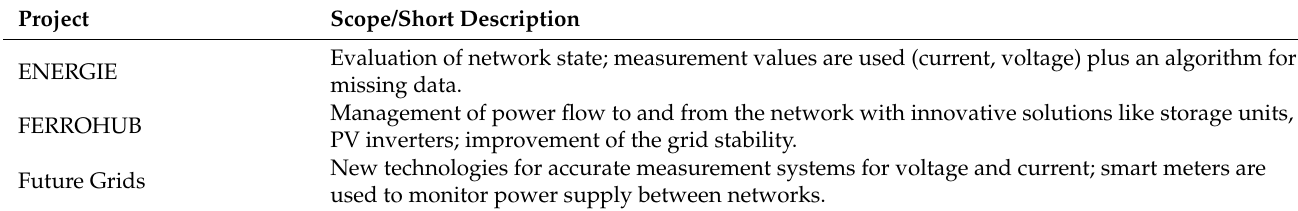
Table 8. Grid Monitoring and control